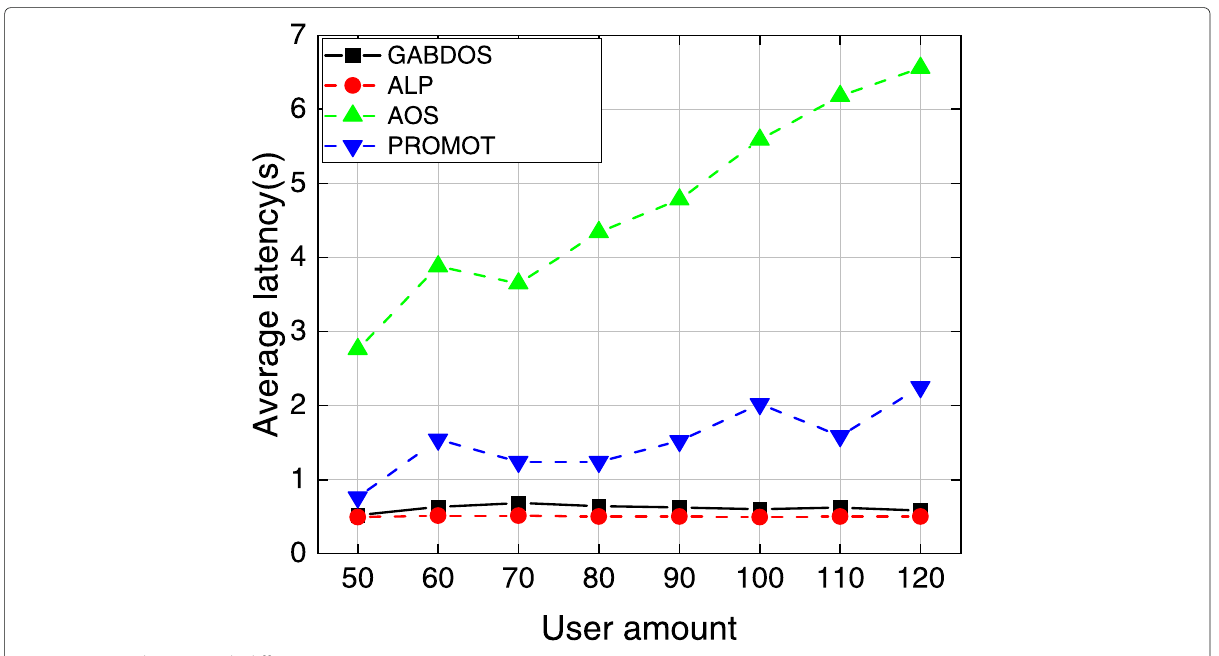
PROMOT is more insensitive to the increase of device CPU frequency since it makes the offloading decision based on prior probability. The reason why the decreas- ing effect of average latency becomes smaller with the computing capacity of mobile devices increasing will be discussed in our future